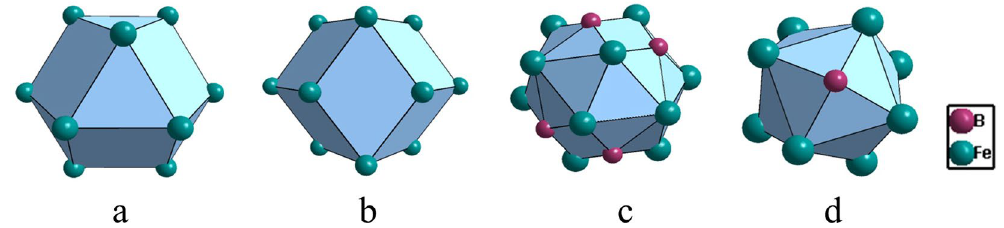
Figure 1. Cuboctahedron CN12 [Fe-Fe 12 ] in FCC γ -Fe ( a ), rhombidodecahedron CN14 in [Fe-Fe 14 ] BCC δ -Fe( b ), and CN15 [Fe-B 4 Fe 11 ] ( c ) and CN10 octahedral antiprism [B-B 2 Fe 8 ] ( d ) in BFe 2 .